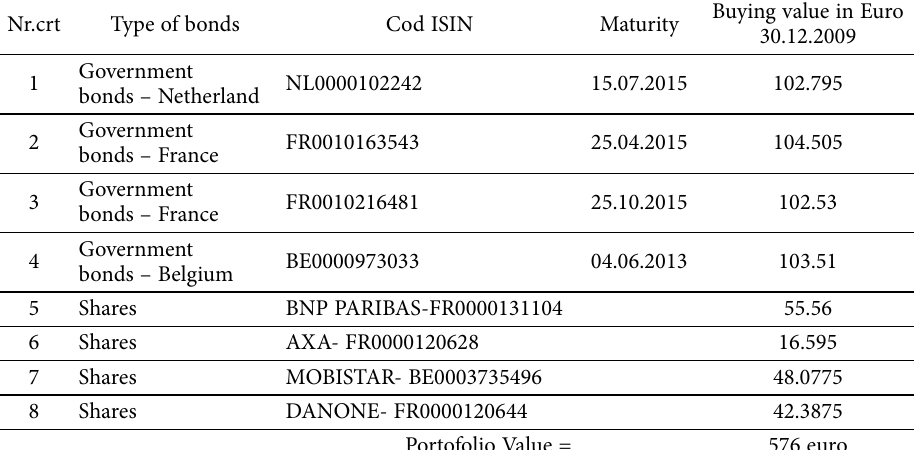
Table 1. Stucture of the hypotetical